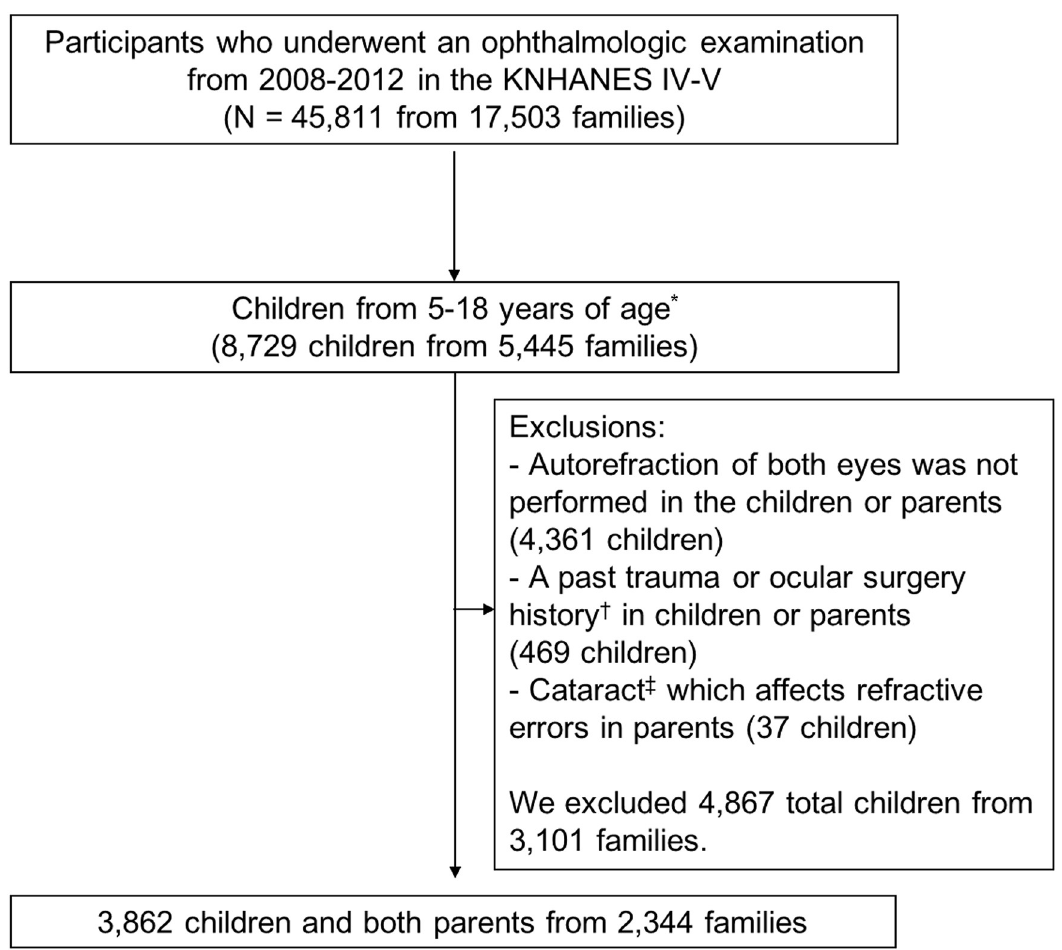
Fig 1. Identification of eligible participants from the 2008–2012 Korean National Health and Nutrition Examination Survey. KNHANES = Korean National Health and Nutrition Examination Survey; � The participants’ ages were not counted in Korean age, but in full. † All types of surgery, including patients with pseudophakia, aphakia, or any history of refractive surgery. ‡ Participants with cataract and a visual acuity of 20/25 or worse as assessed using a Snellen